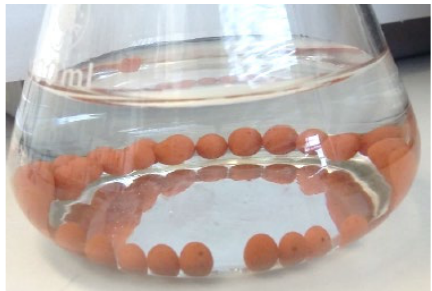
Figure 2. Maghemite PVA-alginate beads in Millipore